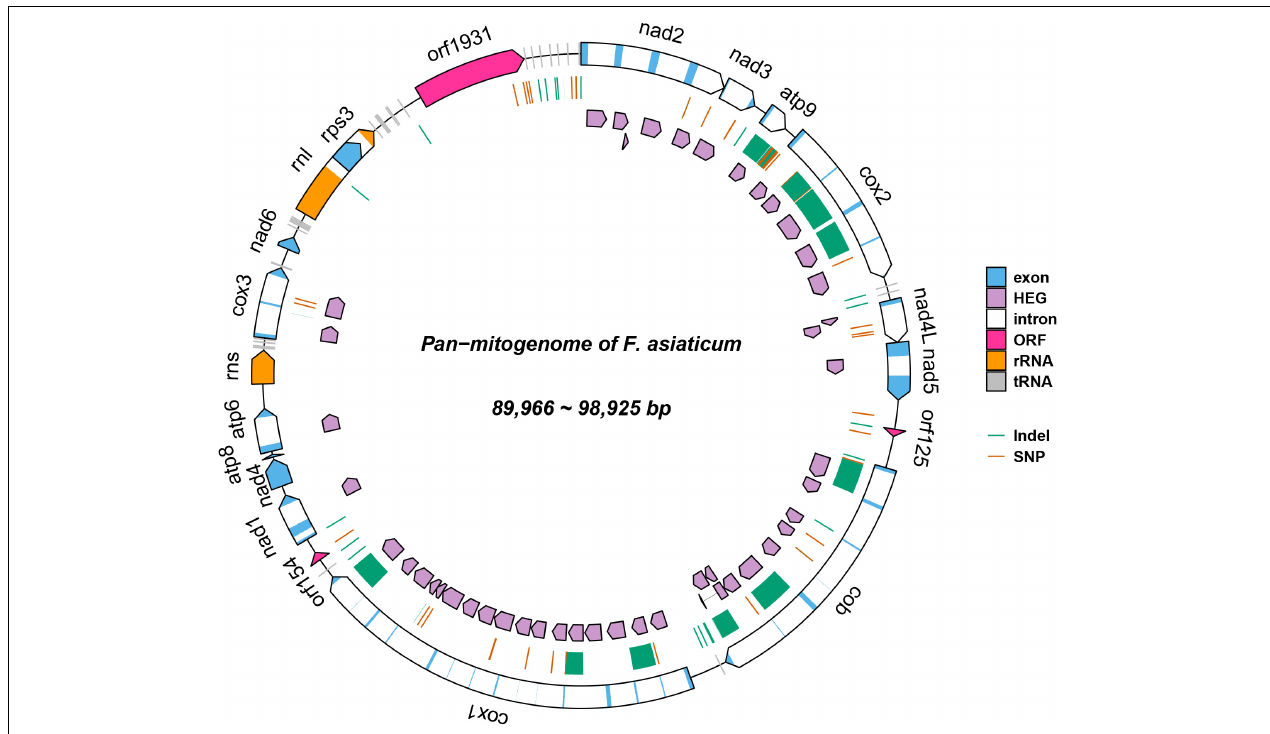
FIGURE 1 | Pan-mitogenome of 210 Fusarium asiaticum isolates. This figure summarizes all the genetic variability observed within the species. Regions affected by indels are highlighted in green and SNPs are indicated in red.